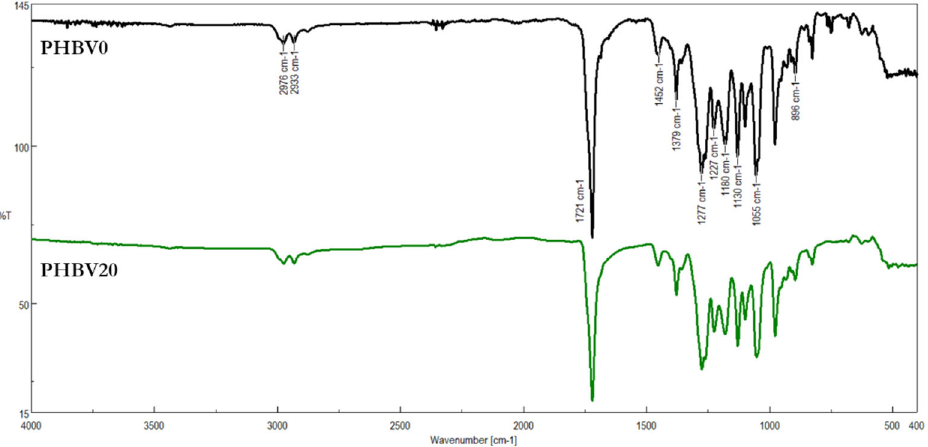
Figure 5. ATR ‐ FTIR spectra of the unmodified (PHBV0) and the modified electrospun fibers Figure 5. ATR-FTIR spectra of the unmodified (PHBV0) and the modified electrospun fibers (PHBV20).